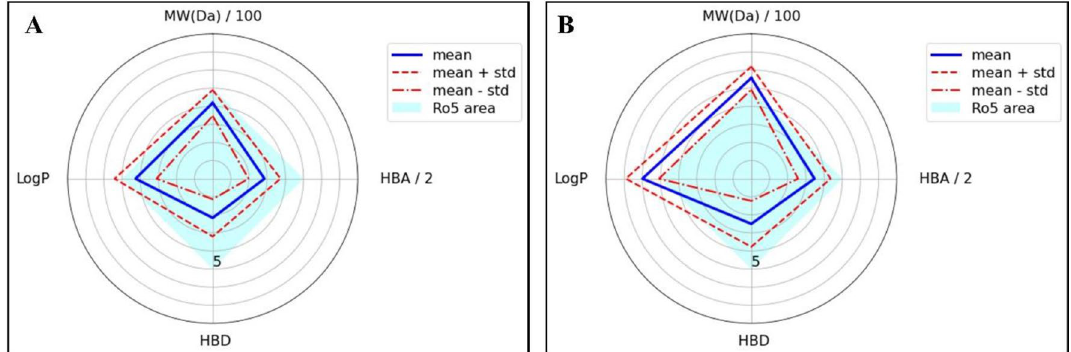
Figure 3. Physio-chemical radar plots of the compounds in the dataset that ( A ) fulfill the Rule of Five (RO5) or ( B ) violate the RO5. Abbreviations: molecular weight (MW), hydrogen bond acceptors (HBA), number of hydrogen bond donors (HBD), and partition coefficient (LogP). The figure is created by using scikit-learn v 0.23.1, https:// scikit- learn.